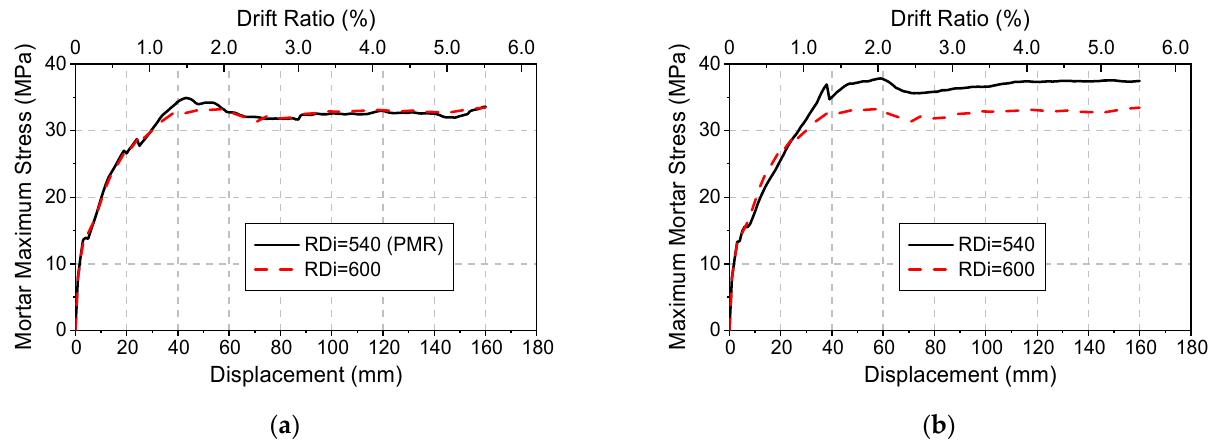
Figure 28. Maximum mortar stress curves with different recess diameters: ( a ) shallow recess (RDe = 50 mm, CT = 20 mm); ( b ) deep recess (RDe = 100 mm, CT = 20 mm).